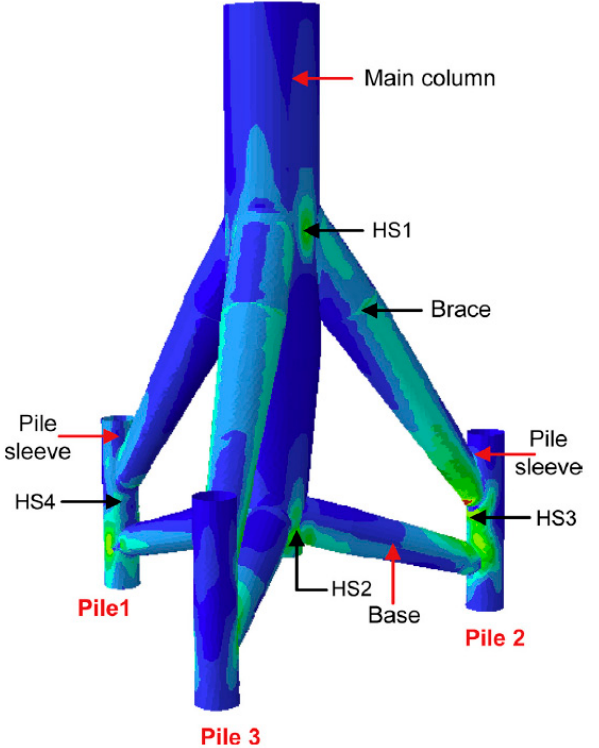
Figure 8. Severe fatigue locations on a tripod foundation (Adapted with permission from ref. [87]. Copyright 2018 Applied Ocean Research). Table 3. Design constraints for the floating offshore platforms